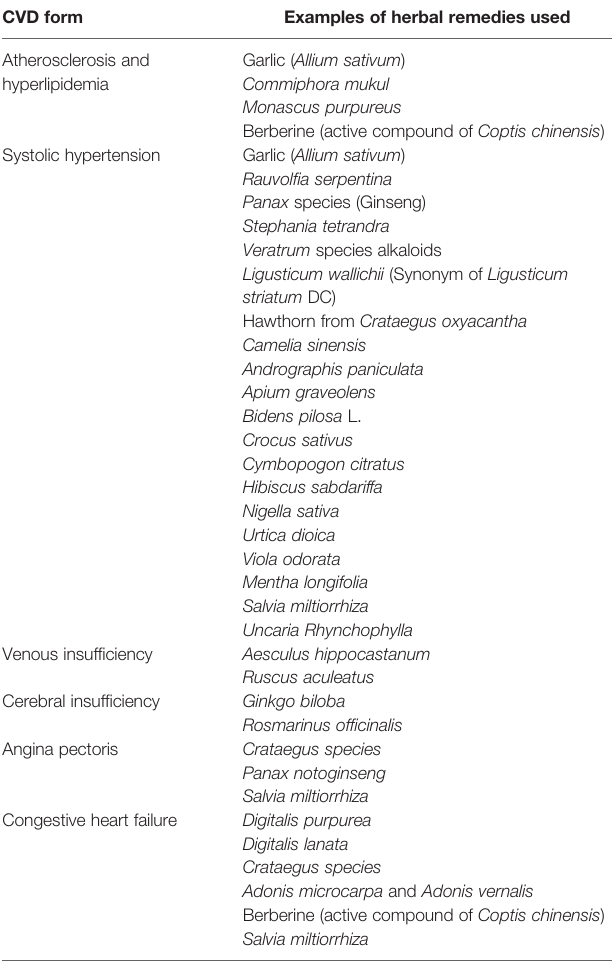
TABLE 1 | Some herbal remedies traditionally used for the treatment of different forms of